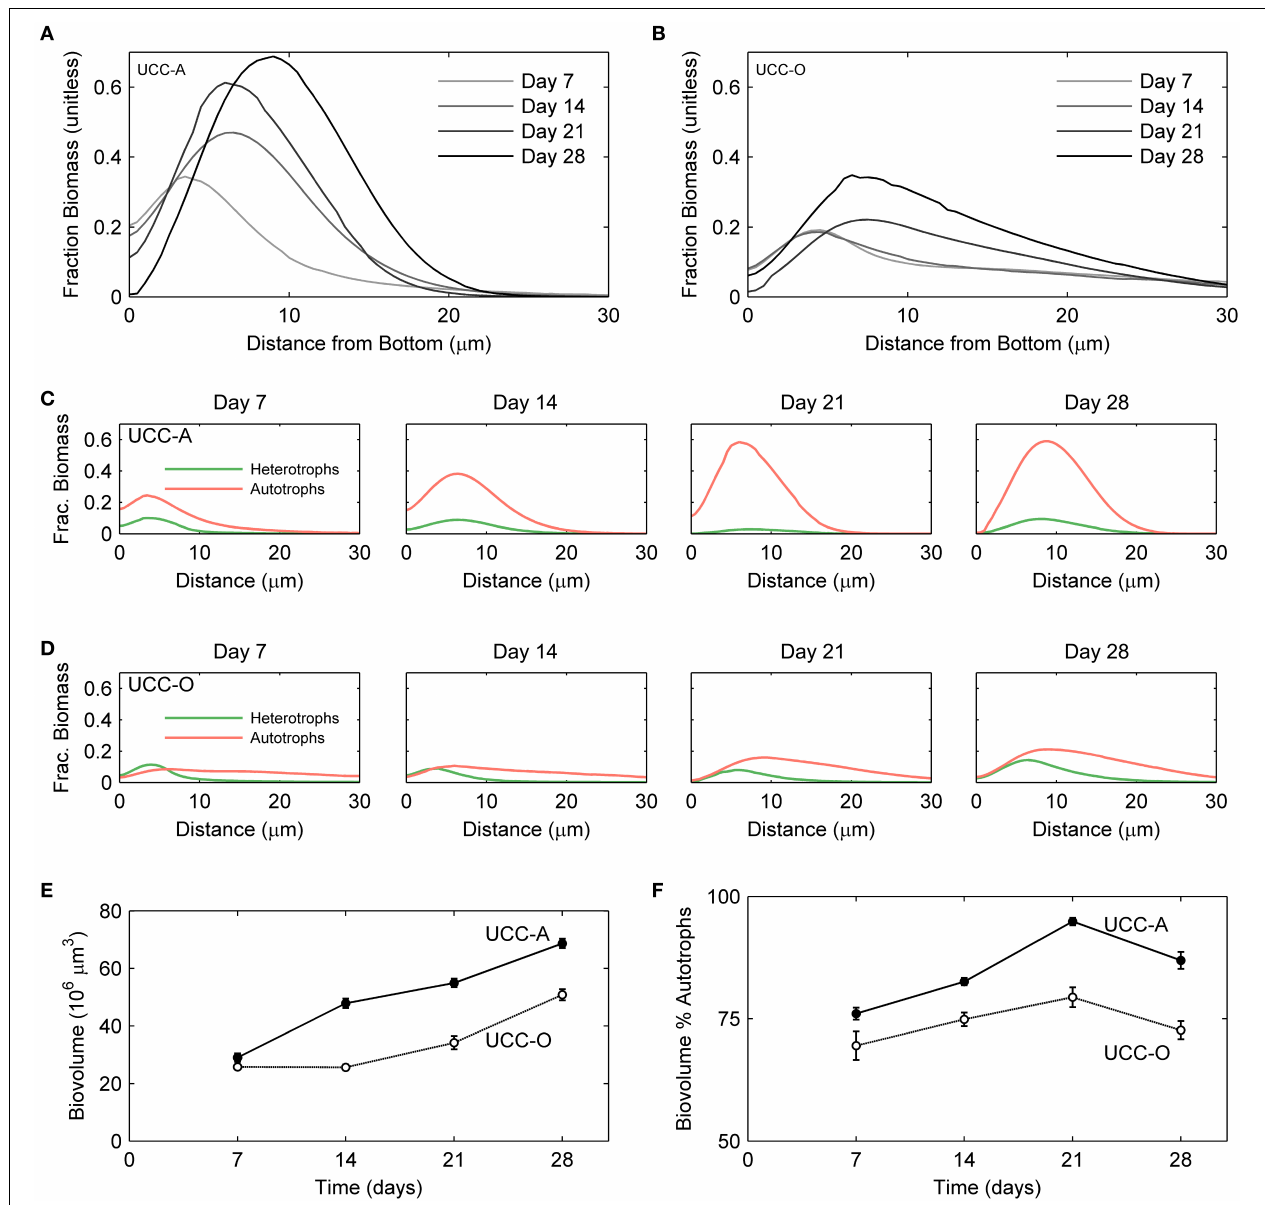
FIGURE 7 | Structural dynamics of autotroph-heterotroph balance in the consortial biofilms quantified by image analysis. The fraction of the measured volume composed of cellular biomass as a function of depth is represented for UCC-A (A) and UCC-O (B) . Increasing darkness of the lines (from light gray to black), represent increasing biofilm age over the colonization period [7 (lightest gray), 14, 21, and